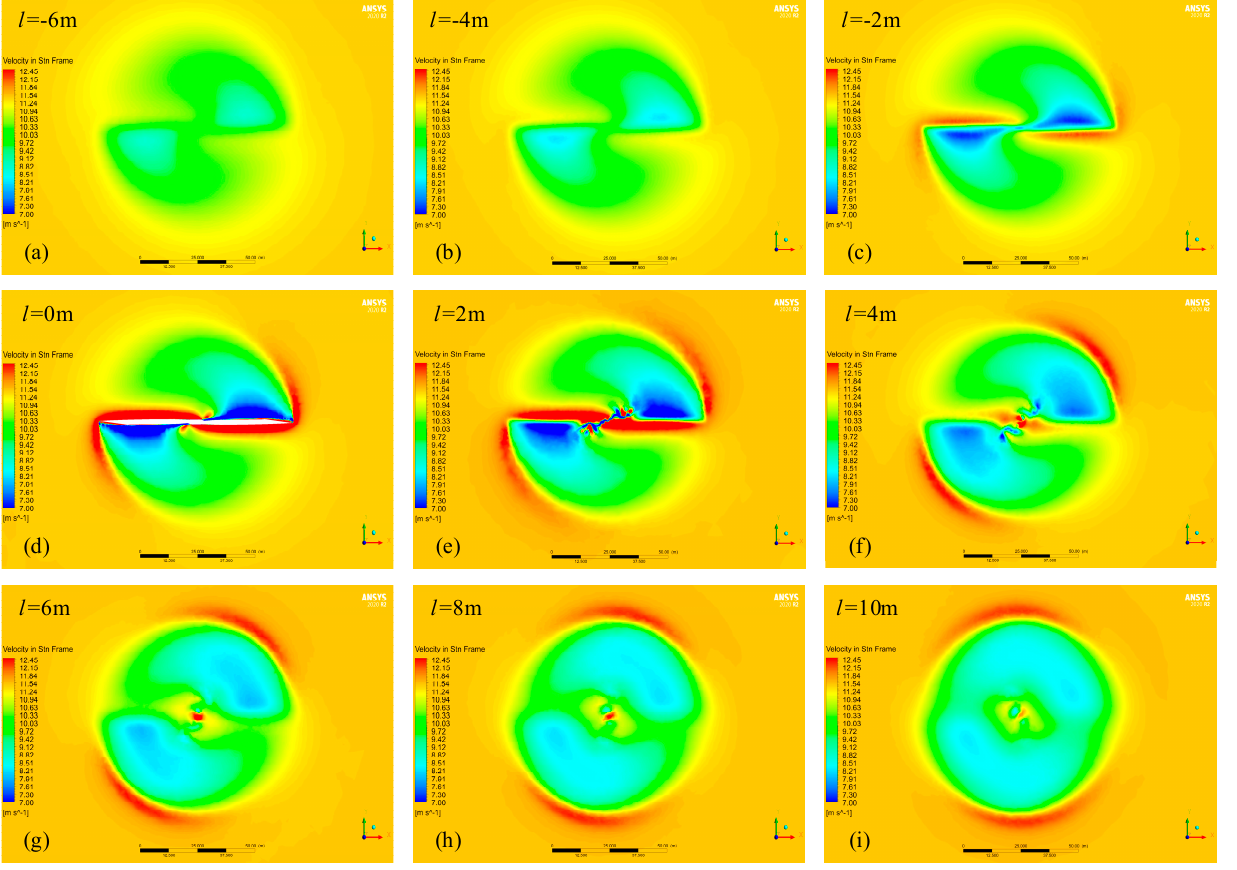
Figure 13. Wind speed cloud map at different locations. ( a ) 6 m away from the front of the wind rotor; ( b ) 4 m away from the front of the wind rotor; ( c ) 2 m away from the front of the wind rotor; ( d ) Wind.rotor plane; ( e ) 2 m behind the wind rotor; ( f ) 4 m behind the wind rotor; ( g ) 6 m behind the wind rotor; ( h ) 8 m behind the wind rotor; ( i ) 10 m behind the wind rotor.